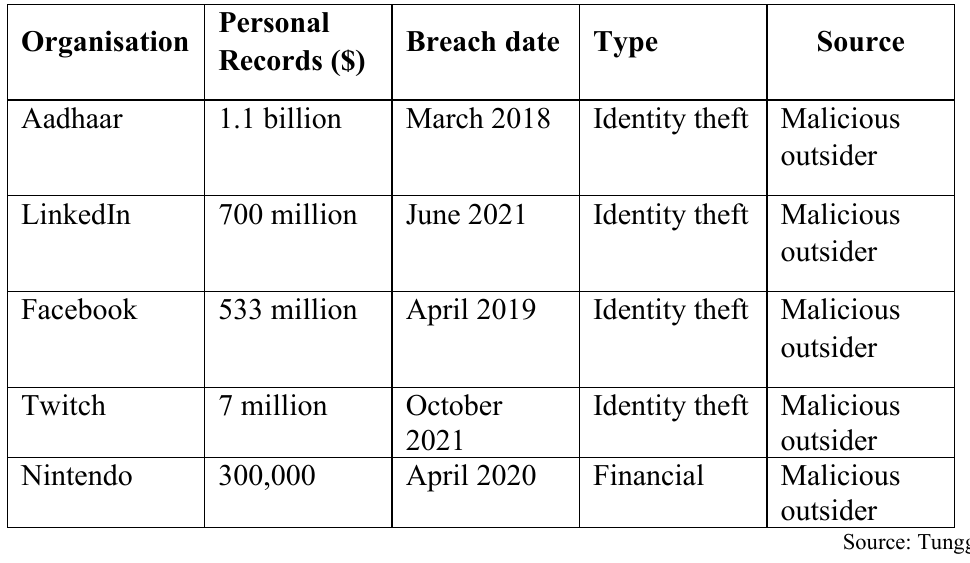
TABLE 3: MASSIVE ENTERPRISE DATA LEAK